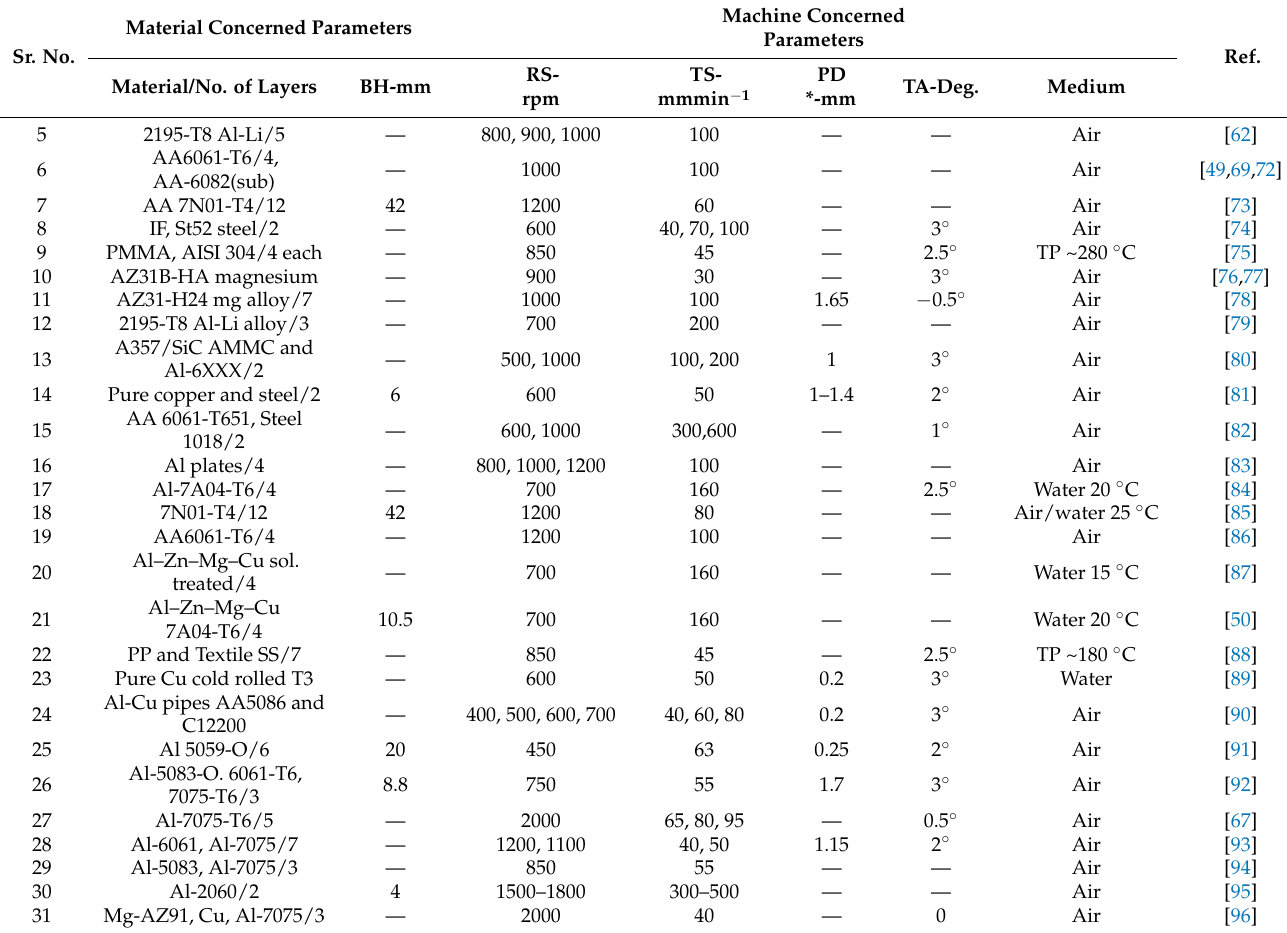
Table 3. Overview of tool concerned parameters applied by the various researchers.